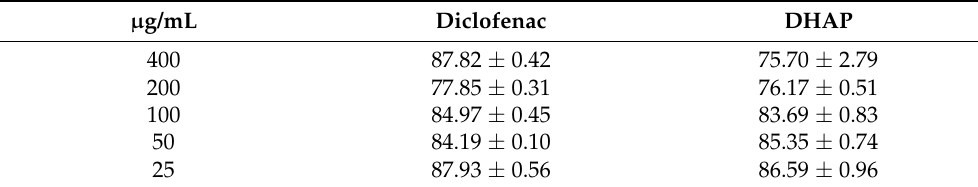
Table 2. Percent human red blood cell membrane stabilization by DHAP.